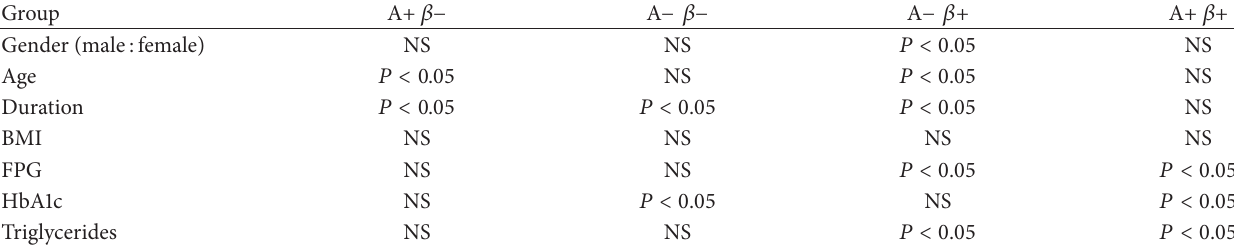
Table 3: Comparison between ketosis-onset and ketosis prone groups ( 𝑃 value).